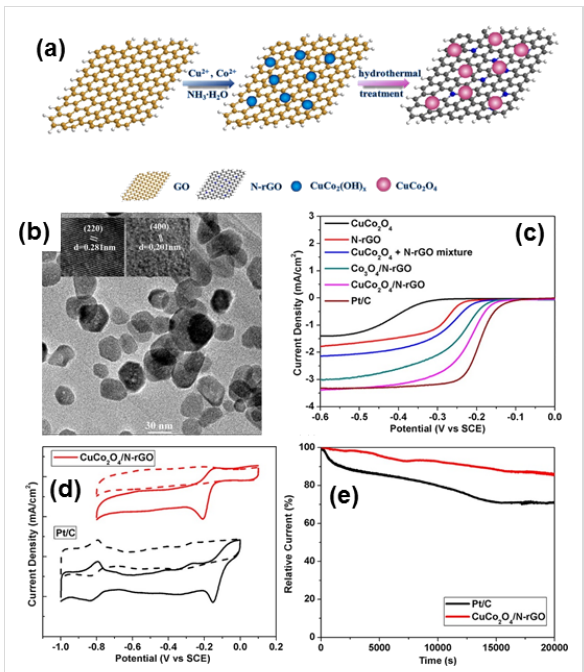
Figure 10: (a) Schematic diagram to illustrate the two-step solvother- mal preparation of the CuCo 2 O 4 /N-rGO hybrid catalyst. (b) High- magnification TEM images of the resulting CuCo 2 O 4 /N-rGO hybrid (insets show HRTEM images of one CuCo 2 O 4 nanoparticle). (c) Linear sweeping voltammograms (LSVs) of the CuCo 2 O 4 /N-rGO hybrid, CuCo 2 O 4 + N-rGO mixture, Co 3 O 4 /N-rGO hybrid, CuCo 2 O 4 , N-rGO, and Pt/C in an O 2 -saturated 1 M KOH solution at 1,600 rpm. (d) CVs of CuCo 2 O 4 /N-rGO and Pt/C in an O 2 -saturated (solid line) or N 2 -satu- rated (dashed line) 1 M KOH solution. (e) Current − time ( i – t ) chronoam- perometric responses for ORR on CuCo 2 O 4 /N-rGO and Pt/C catalysts at − 0.3 V in an O 2 -saturated 1 M KOH solution at a rotational rate of 200 rpm. Reprinted (adapted) with permission from [309], copyright 2013 American Chemical